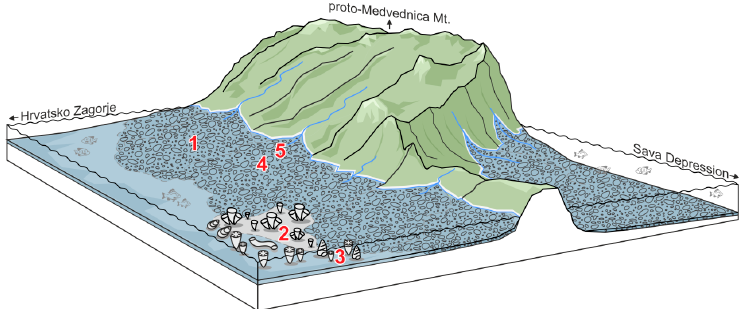
Figure 12. Depositional model of Late Cretaceous clastic deposits in the studied area with presumed positions of localities shown on Figure 2: (1) Falati; (2) Mikuli´c Potok Creek; (3) Mali Potok Creek; (4) Road to Kraljiˇcin Zdenac; (5) Studied